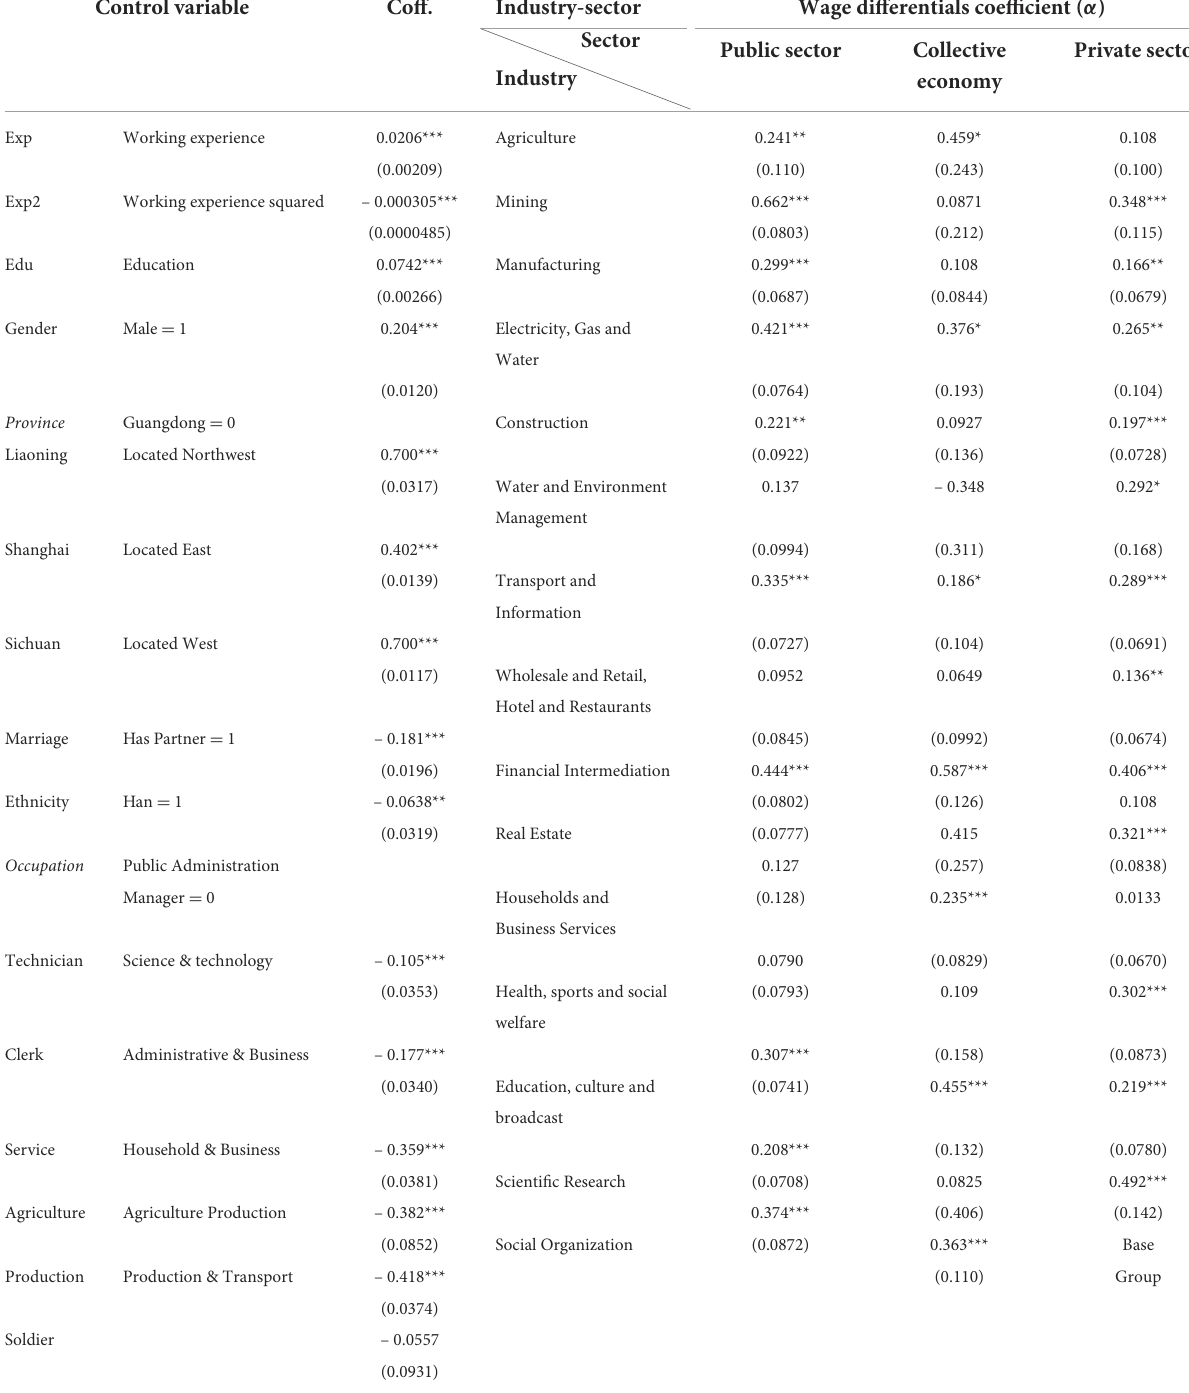
TABLE 3 First-stage estimation for